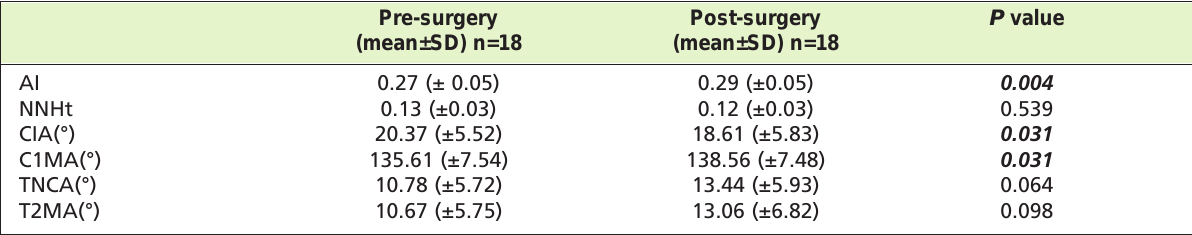
Arch index and radiograph measurements pre- and post-surgery Table II: Pre-surgery